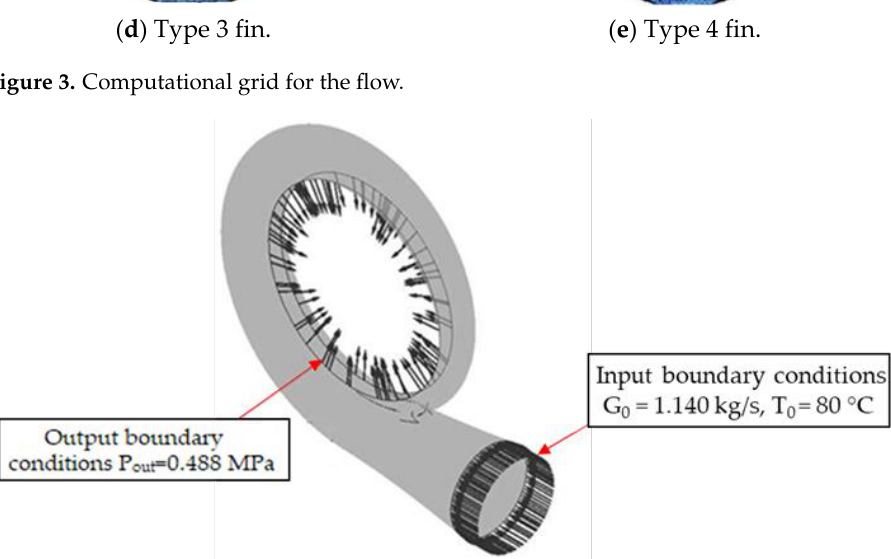
Figure 3. Computational grid for the flow.